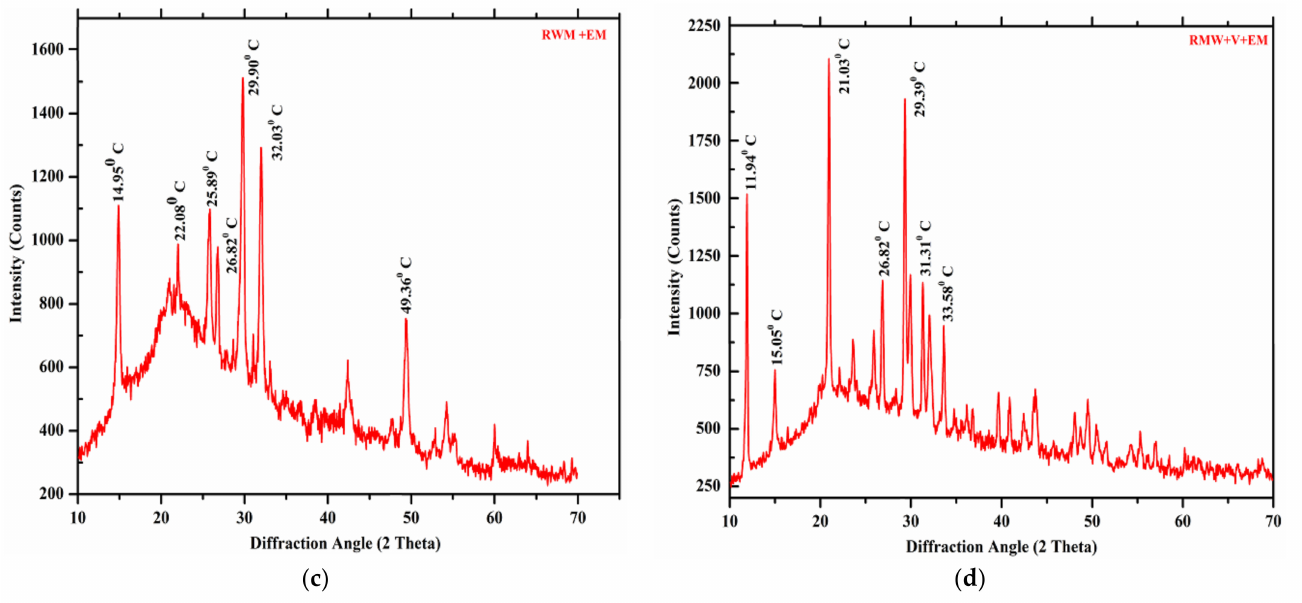
Figure 11. XRD analysis of the sample ( a ) [MW+EM], ( b ) [MW+V + EM], ( c ) [RWM+EM], and ( d ) [RMW+V+ EM].